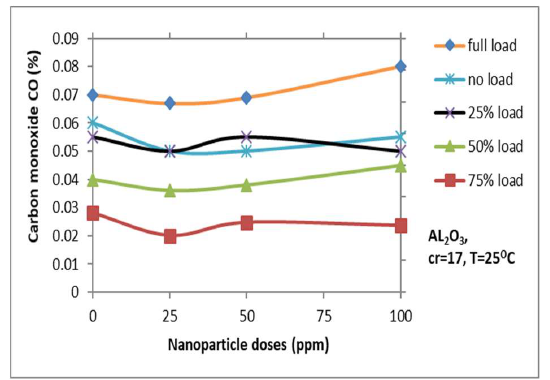
Fig. 4. variation of the carbon monoxide with Alumina nanoparticles doses.